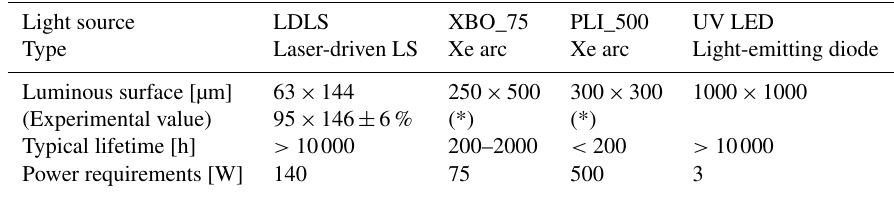
Table 2. Specifications of several lamps used for LP-DOAS measurements.